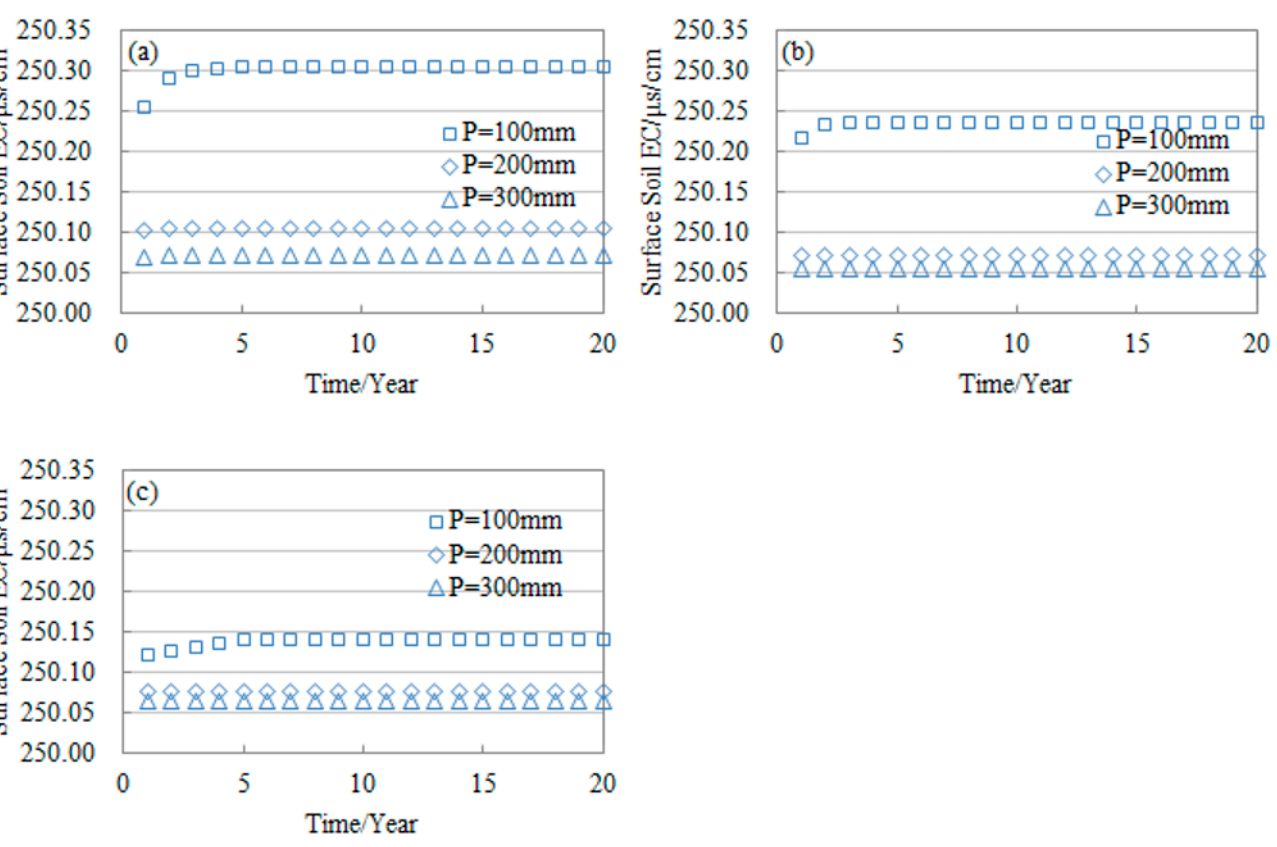
Figure 10. Annual variation in topsoil salinity under three irrigation methods and under different precipitation conditions. ( a ) Mulched drip irrigation; ( b ) shallow-buried drip irrigation; ( c ) sprinkler irrigation.